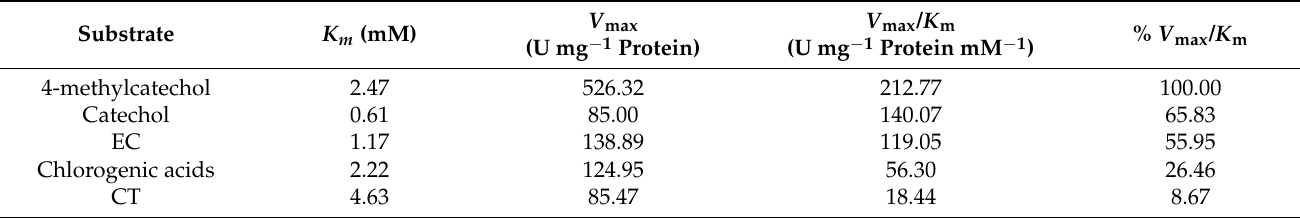
Table 2. Substrate specificity of dimeric PPO from Huaniu peel.